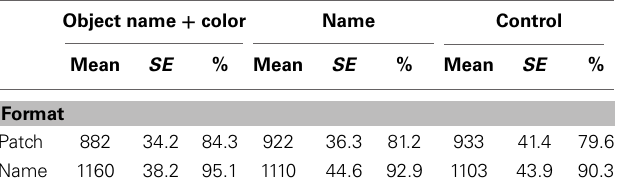
Table 2 | Experiment 2: Mean response times, standard error (SE), and percentage correct (%) for object shape and color in the lexical/semantic matching